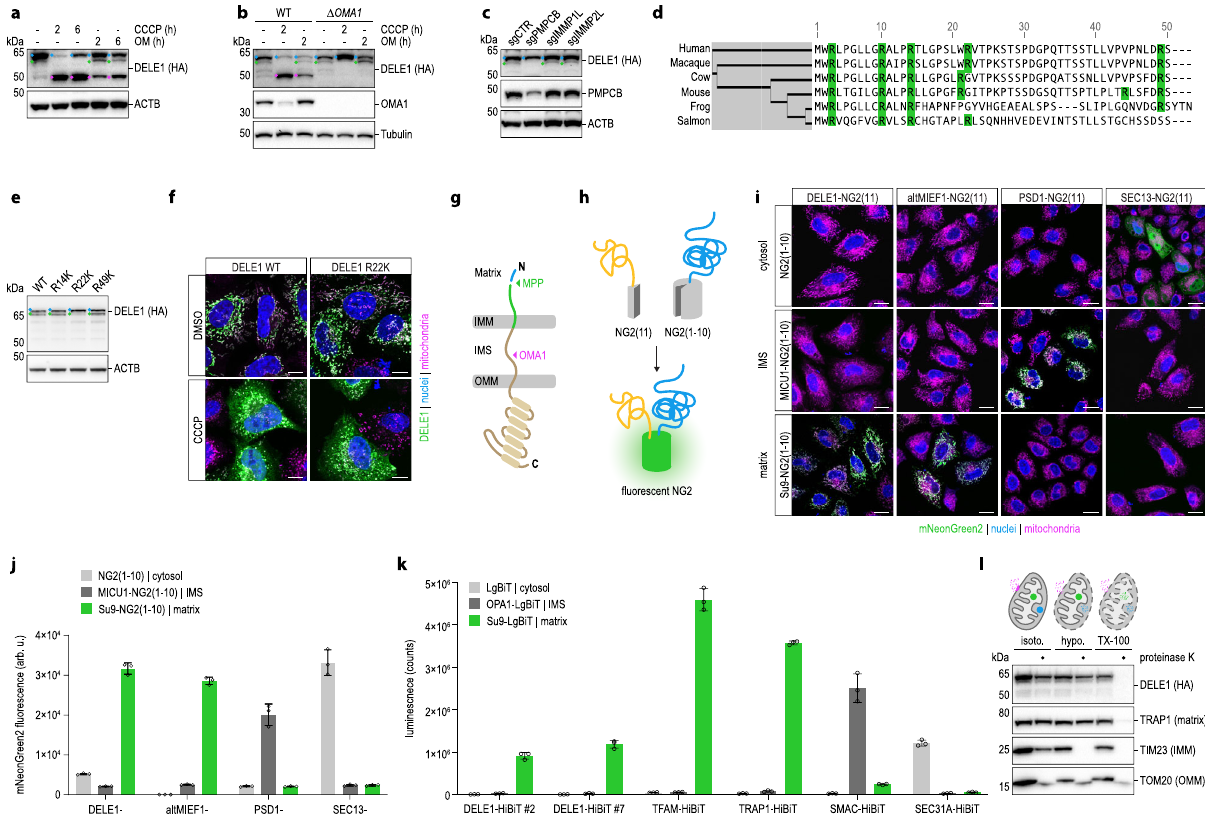
Fig. 2 DELE1 is a substrate of MPP that can be fully imported into the mitochondrial matrix. a HeLa DELE1 HA cells treated as indicated and analyzed for endogenous DELE1 protein by immunoblotting. OM, oligomycin. Blue, L-DELE1. Green, M-DELE1. Pink, S-DELE1. b 293 T DELE1 HA WT and OMA1 knockout ( Δ OMA1 ) cells treated as indicated and analyzed by immunoblotting. c HeLa DELE1 HA cells exposed to sgRNAs targeting the indicated genes for six days and analyzed by immunoblotting. d Alignment of the fi rst 50 amino acids of DELE1 from different species. Arginines highlighted (green). e Wild-type DELE1 or the indicated arginine to lysine mutants transiently expressed in HeLa cells. Cell lysates analyzed by immunoblotting. f Confocal microscopy of HeLa cells transfected with indicated DELE1 variants. Scale bars,10 μ m. Nuclei (DAPI, blue), mitochondria (MitoTrackerRed, pink), DELE1 (HA, green). g Schematic illustrating DELE1 import into mitochondria and its processing by MPP and OMA1. IMM, inner mitochondrial membrane. IMS, intermembrane space. OMM, outer mitochondrial membrane. h Principle of split mNeonGreen2 (NG2) complementation by fusion of the small (NG2(11)) and the large (NG2(1-10)) component to different proteins (yellow, blue) sorted into the same subcellular compartment. i Localization of DELE1 in HeLa cells analyzed via split NG2 system by confocal microscopy. NG2(11) was C-terminally fused to DELE1, altMIEF1, SEC13 or the sorting signal of PSD1 and co-expressed with NG2(1-10) directed to different subcellular compartments by fusion with the sorting signals of MICU1 or Su9. Scale bars, 20 μ m. Nuclei (DAPI, blue), mitochondria (MitoTrackerRed, pink), mNG2 (green). j NG2 fl uorescence as in ( i ) measured by fl ow cytometry. Mean ± s.d. of n = 3